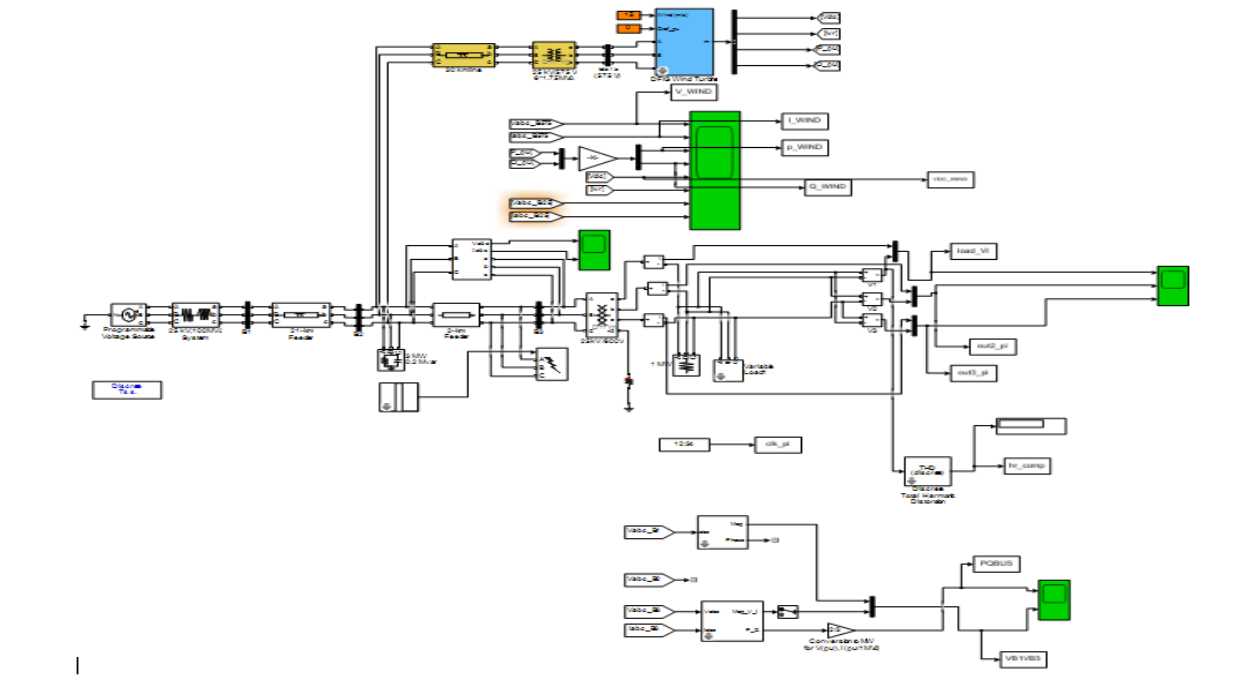
Figure 4. Proposed Simulink